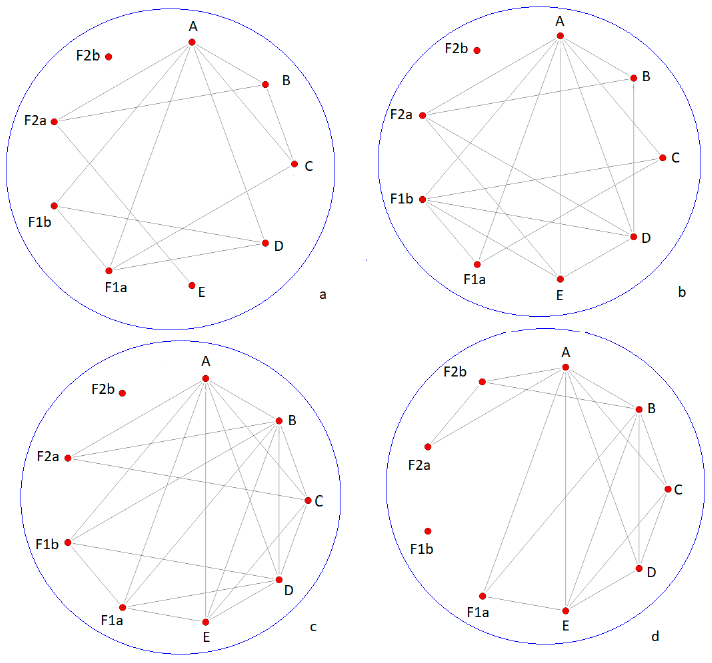
Figure 4. Network models of the co-occurrences of concepts and sub-concepts per age group: 20–30 ( a ), 30–40 ( b ), 40–50 ( c ), and 50–60 ( d ) for question Q 2 .